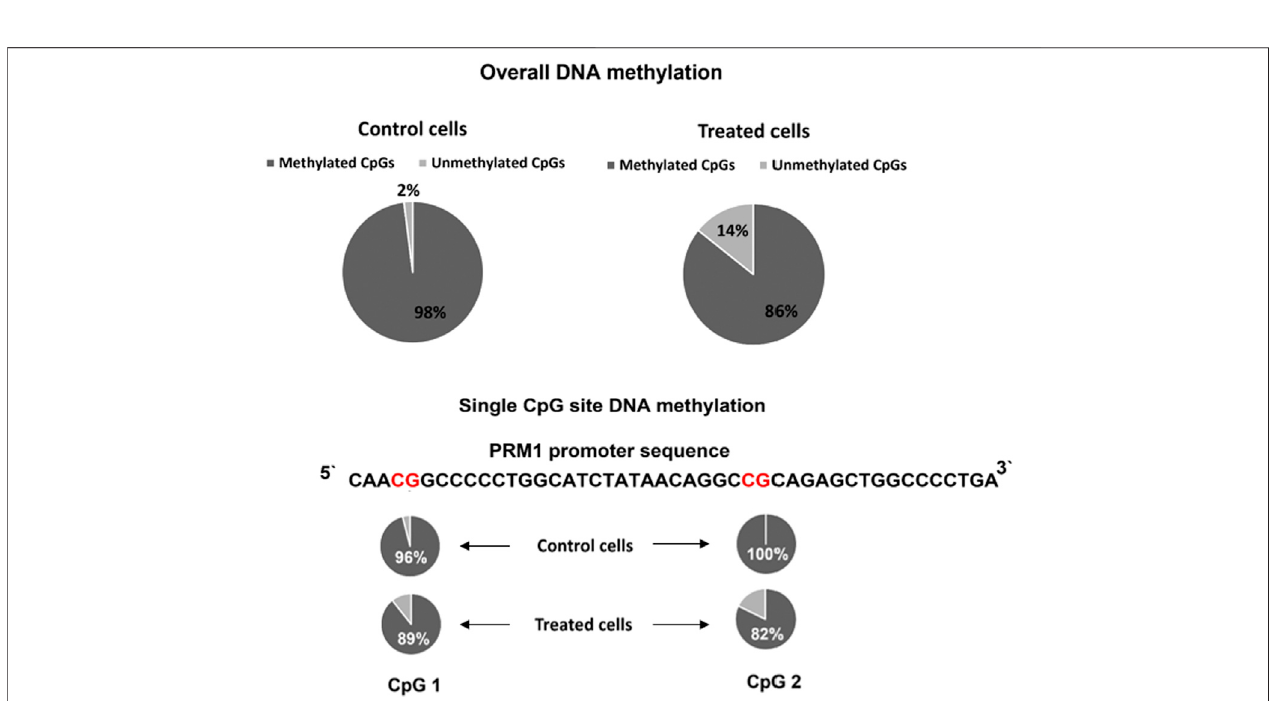
FIGURE5| PRM1 promoterregionDNAmethylationpattern incontrolandtreatedcells.OverallmethylationandsingleCpGsitemethylationlevelsareshown.The percentageofDNAmethylationpersequencewascalculatedusingthefollowingformula:numberofmethylatedCpGsites/totalnumberofsuccessfullysequencedCpG sites. The BISMA online tool was used to assess the methylation